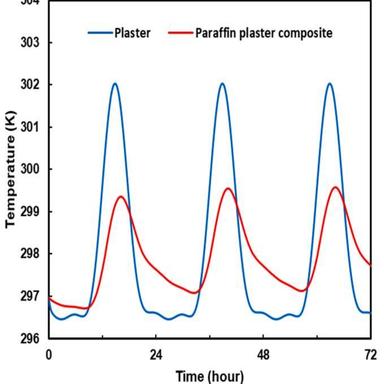
Evolution of the temperature as a function of time for plasterboard panels without and with PCM composite.